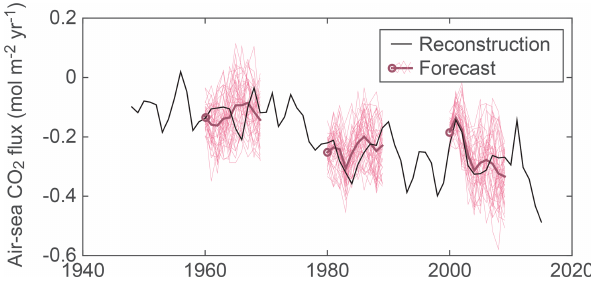
Figure 1. Annual mean air–sea CO 2 flux (molm − 2 yr − 1 ) in the South Pacific subtropical permanently stratified biome for the (black) model reconstruction and (pink) CESM-DPLE decadal fore- casts initiated in 1960, 1980, and 2000 (other forecasts omitted for visual clarity). The thick magenta line represents the ensem- ble mean forecast; open circles show the ensemble mean in forecast year 1. Positive fluxes denote ocean outgassing. Forecasts have been drift-corrected and adjusted to match the reconstruction climatolog- ical mean for ease of visual